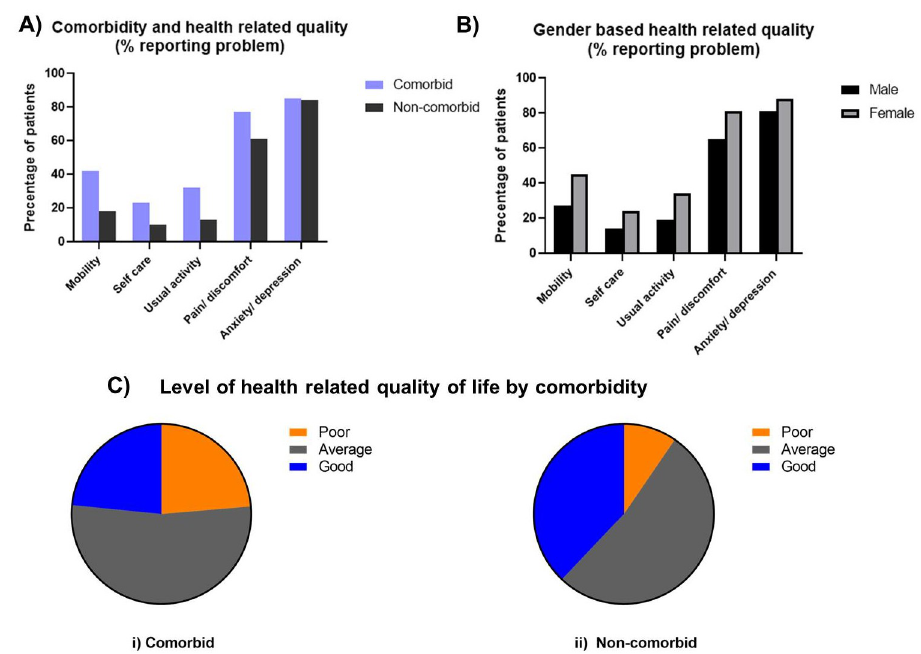
Fig 2. Effect of comorbidity on health-related quality. A) Comparison between the presence of various health- related problems among comorbid and non-comorbid T2D patients; B) Comparison between health related quality of life of male and female; C) HRQoL among comorbid and non-comorbid